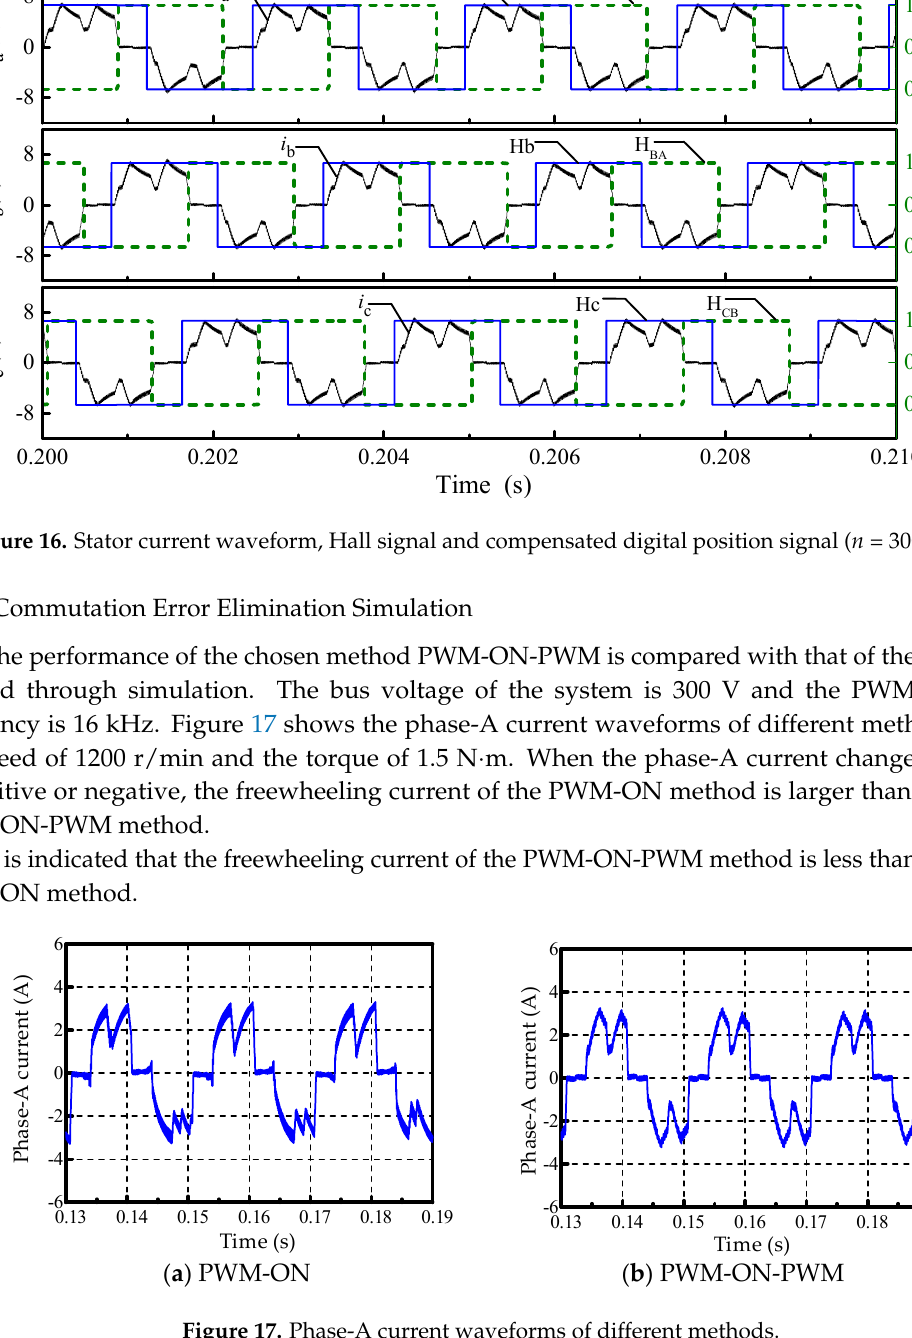
Figure 17. Phase-A current waveforms of different methods.